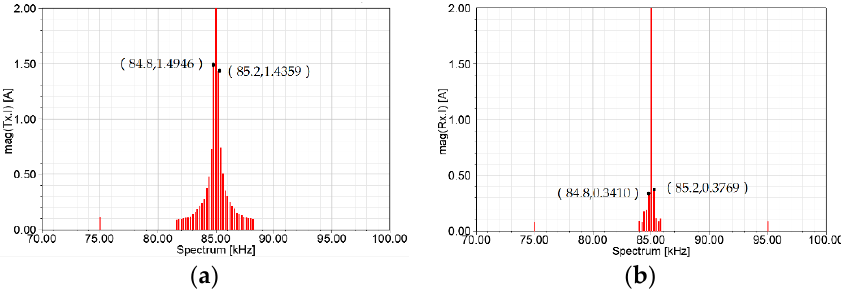
( b ) Figure 16. Magnetic field strength: ( a ) test points of A2, A3, A4; ( b ) test points of B1, B2, B3. Apart from A1 located in the transmission region, the magnetic field strength at A3 is larger than 30.4 A/m required by SAE J2954 at 40% offset and 50% offset. The magnetic field strength under other offsets are not exceeded. The effective magnetic field between the coupling coils decreases with the increase of the offset. When the offset ratio exceeds 10%, the magnetic field of A2 drops greatly, which is close to a negative correlation. When the offset is less than 20%, the field at A3 is nearly invariable. However, after this ratio is exceeded, the amount of magnetic field leakage continues to increase, and after more than 40%, the exceeding strength appears. As the offset increases, the primary coil on the